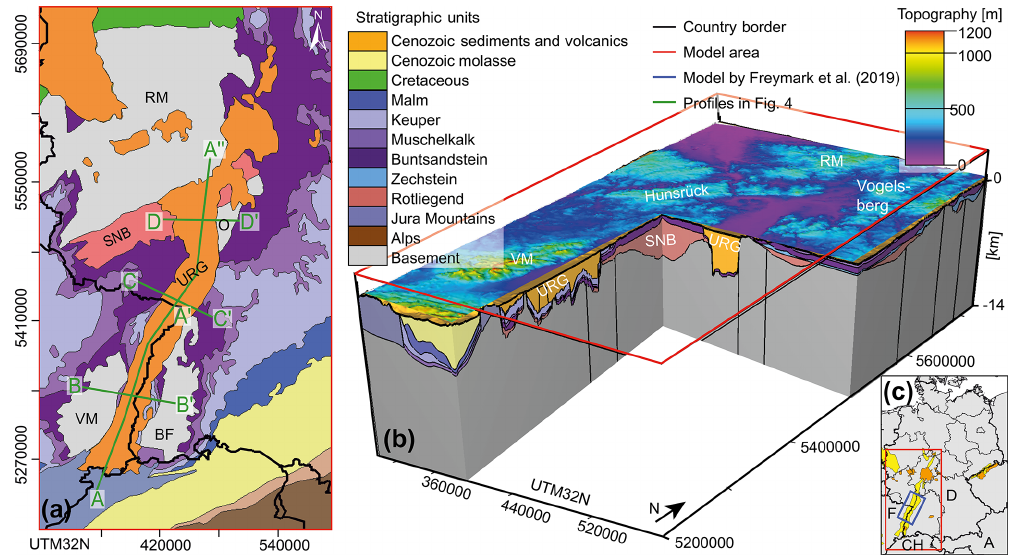
Figure 1. (a) Geological map modified after BGR (2014) of the model area; (b) structural model (after Freymark et al., 2017) used as a base for the numerical model; (c) overview map of model area in red and of previous work by Freymark et al. (2019) in blue. RM: Rhenish Massif, SNB: Saar–Nahe Basin, O: Odenwald, VM: Vosges Mountains, BF: Black Forest (changed according to Freymark et al., 2017). The URG is limited by border faults along its eastern and western margins that are represented as lateral changes in the bordering lithologies but not considered distinct features in the structural